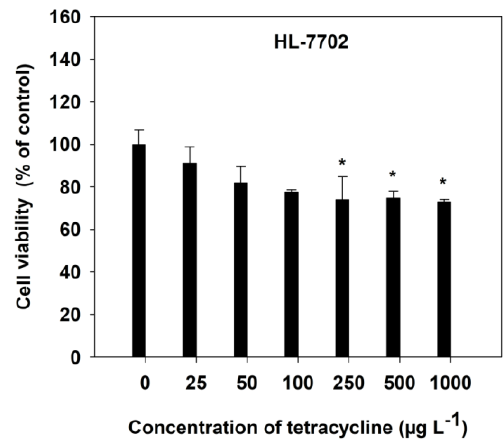
Figure 1. Effect of TC on cell viability in HL-7702 cells after 4-h incubation. Data are given as mean